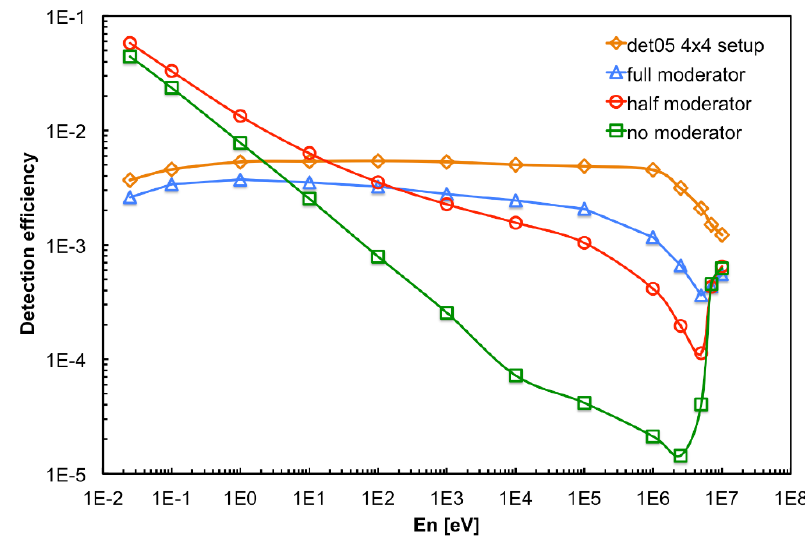
Figure 5. Simulated neutron detection efficiency in different moderator configurations (see the text for